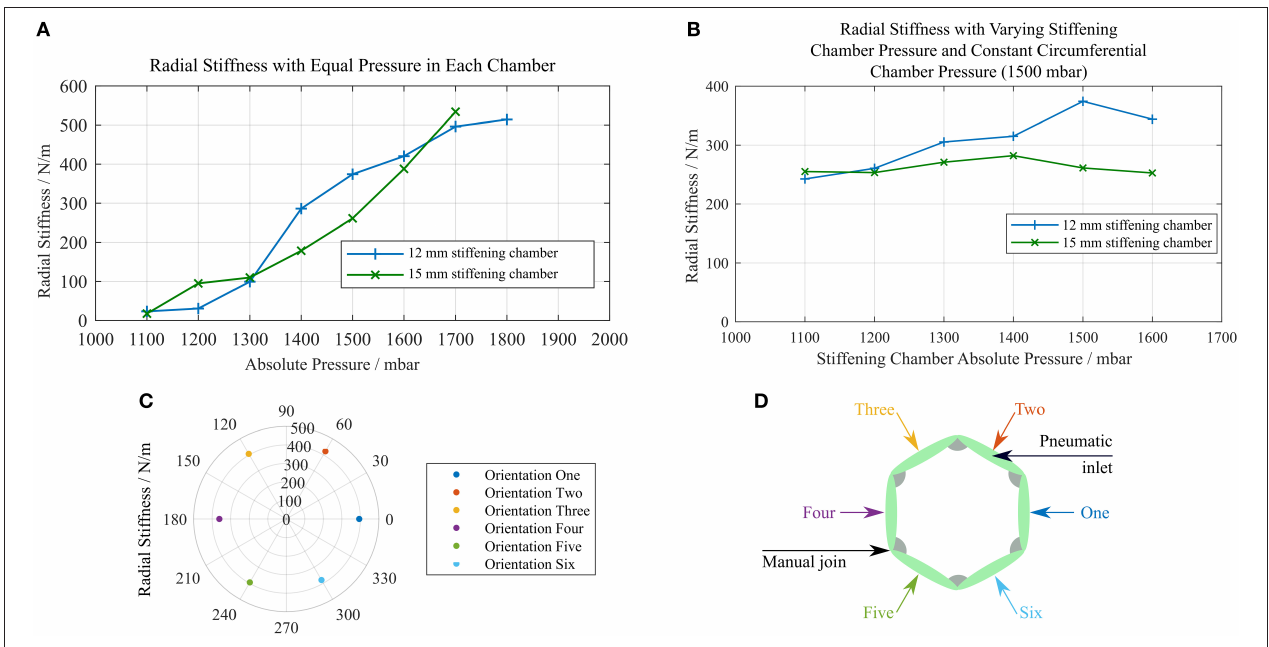
FIGURE 8 | Plots of radial stiffness against chamber pressure (A) stiffness of identical structures with 12 and 15mm stiffening chambers with equal pressure in each layer (B) stiffness of each structure with a constant circumferential chamber pressure of 1,500 mbar and varying stiffening chamber pressure (C) radial stiffness measured at six different orientations (D) diagram showing which face was in contact with the force sensor for each orientation in (C) .